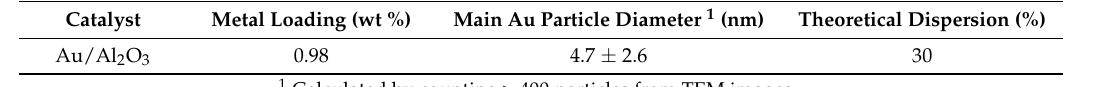
Table 5. Main characterization results of the catalyst used in this